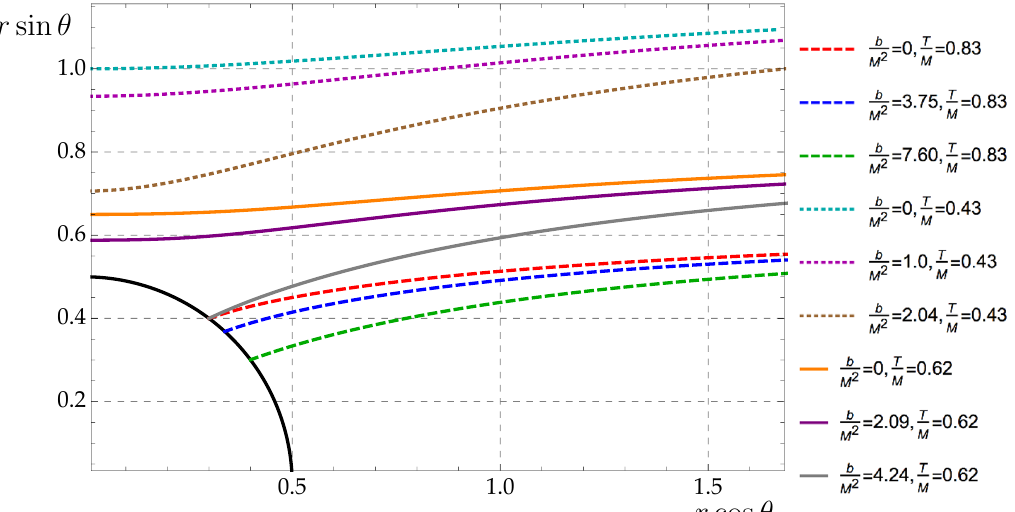
Figure 2 . Pro(cid:12)les for various D7-brane embeddings in the ( r cos (cid:18); r sin (cid:18) )-plane. The black circle represents the horizon at r h = 1 =